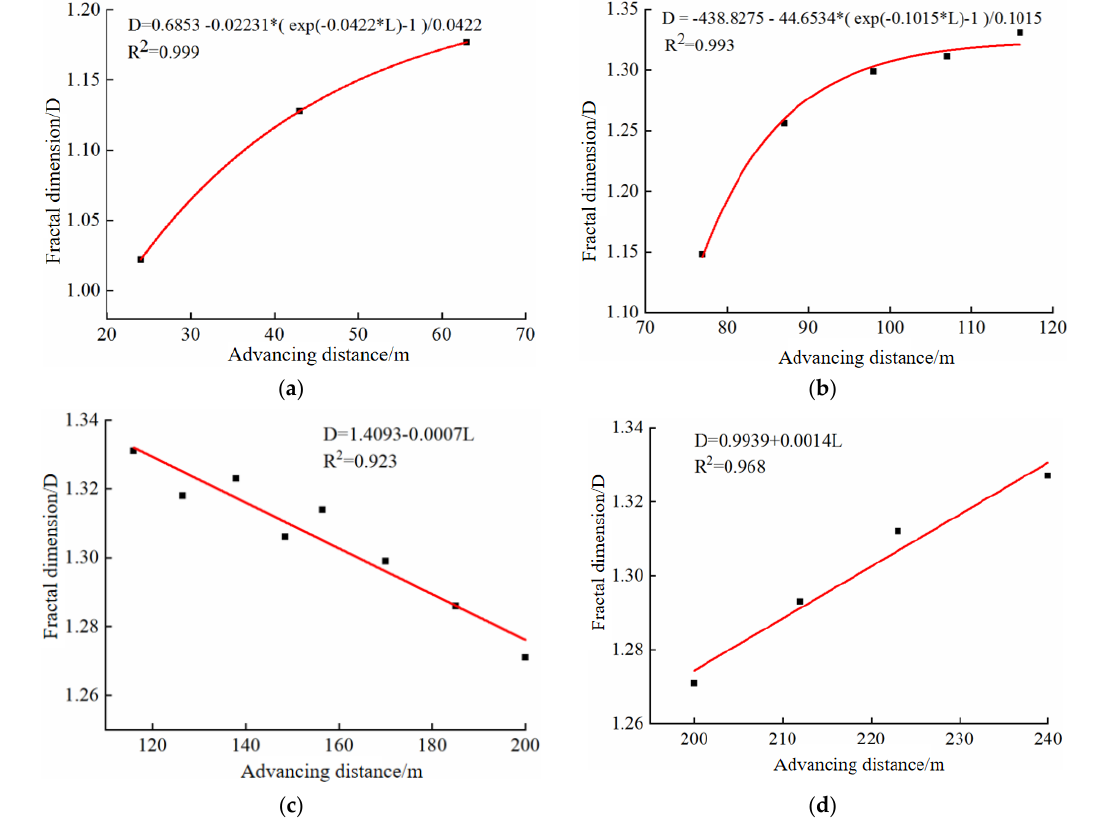
Figure 12. Fitting curve between fractal dimension of each stage and advancing distance of working face. ( a ) The first stage; ( b ) The second stage; ( c ) The third stage; ( d ) The fourth stage.